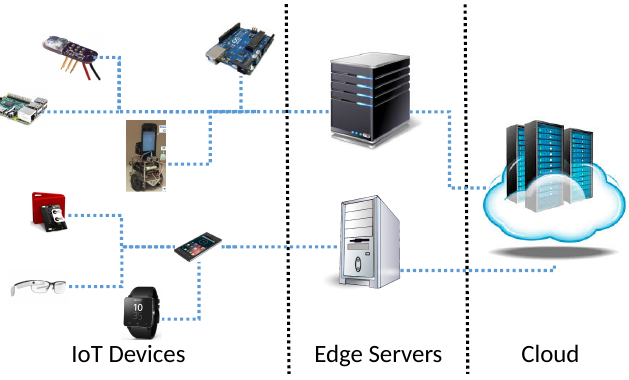
Figure 2. Overall System